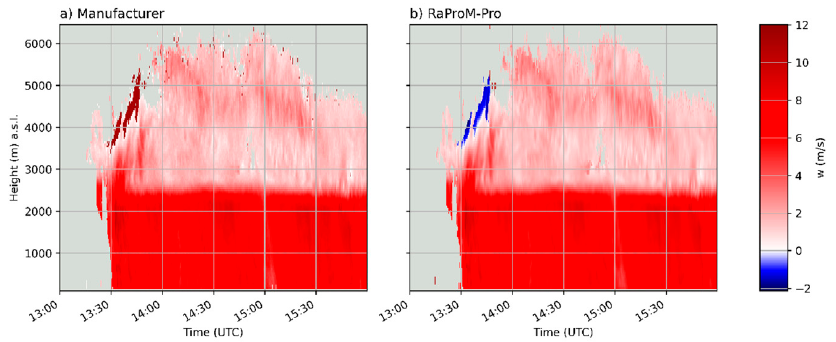
Figure 6. Time–height display of Doppler vertical velocity (positive values indicate downward direction) obtained with MRR- Pro on 16 May 2020 processed with: ( a ). The manufacturer’s software, ( b ). RaProM- Pro , which includes a new dealiasing scheme.